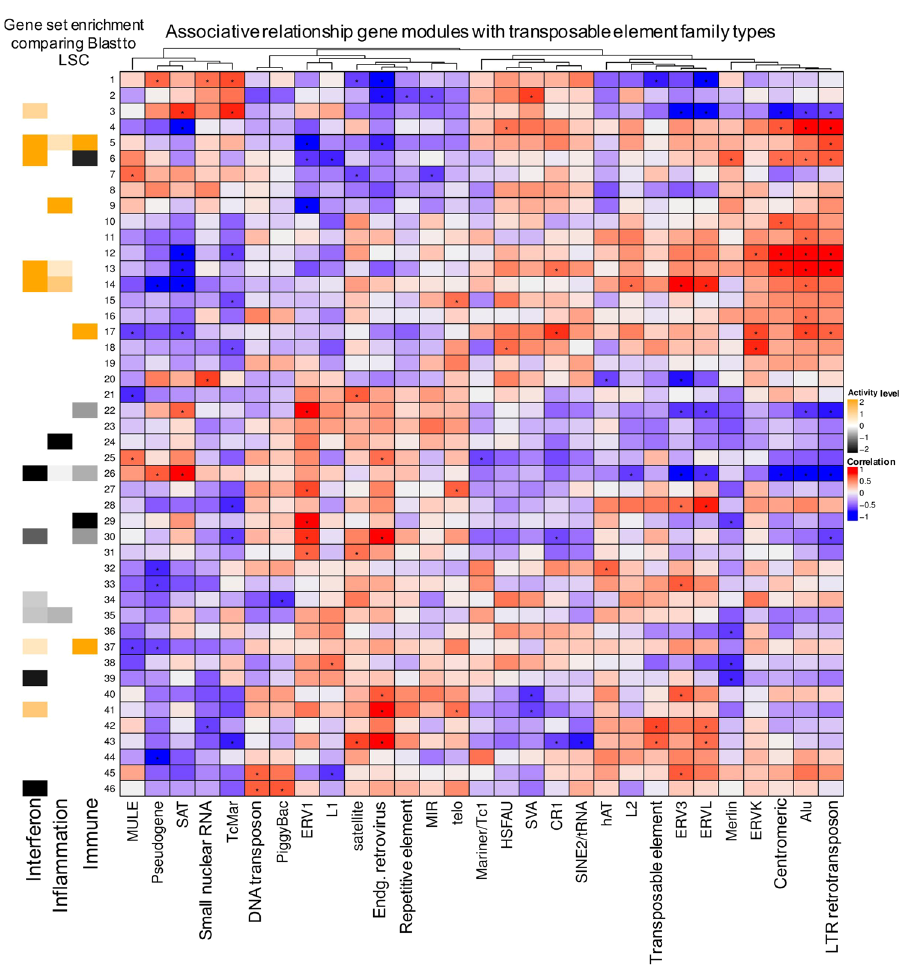
Figure 4. Identifying significant associations between the expression of coding gene network and the transposable element types in AML. The numbers on the Y-axis denote the gene ‘modules’ constructed by identifying gene networks based on co-expression patterns. The X-axis denotes canonical TE types used for correlating them. The centre figure of squares represents the correlation matrix for the normalized gene ‘module’ expression and the TE type. * indicates significant associations (p.value ≤ 0.05). Each gene ‘module’ was tested for activation of canonical immune and inflammation gene sets in Blasts and compared with LSCs. The significant (p.value ≤ 0.05) pathway activity level for each module is plotted on the left of Y-axis (yellow indicates significantly higher activation in Blast, and black indicates significantly higher activity in